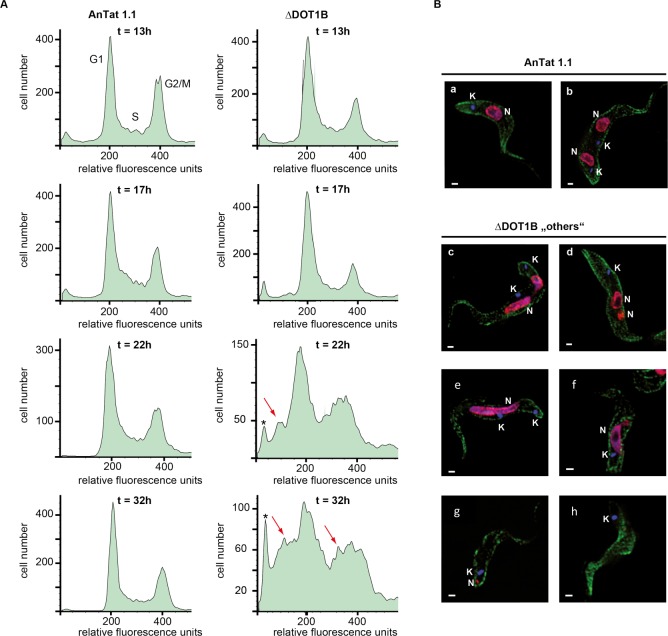
Differentiation defect of ∆DOT1B trypanosomes.(A) Cell cycle profiles of propidium iodide stained differentiating trypanosomes (flow cytometry). ∆DOT1B cells re-enter the cell cycle normally (t = 13h). Later in differentiation (t = 22h; t = 32h) the profiles show peak broadening indicating the appearance of cells with abnormal DNA content (red arrows) and enucleated “zoids” (asterisks). (B) Indirect immunofluorescence analysis of differentiating ∆DOT1B trypanosomes with karyokinesis defects (t = 22h). Wild-type cells shows normally shaped nuclei and kinetoplasts (a: 1N1K, b: 2N2K). During differentiation ∆DOT1B cells are unable to divide their nucleus properly resulting in cells with two kinetoplasts and one elongated or asymmetrically divided nucleus (c-f). Cytokinesis is not impaired demonstrated by the appearance of cells with asymmetrically divided nuclei and one kinetoplast (g) or anucleated “zoids” (h) (green: tubulin; red: histone 3; blue: DAPI; bars: 1 μm).